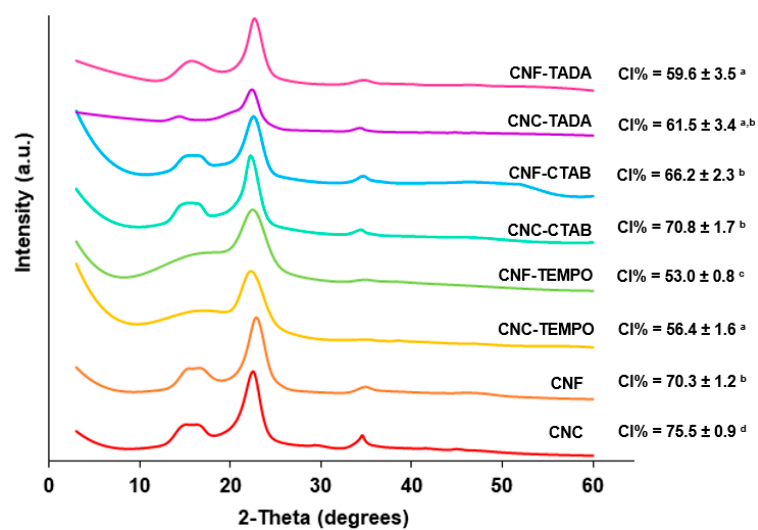
Figure 3. Powder X-Ray Diffraction analyses of the modified and unmodified cellulose nanocrystals (CNC) and cellulose nanofiber (CNF) materials. Nanocellulose modifications have been performed with cetyltrimethylammonium bromide (CTAB), tannic acid and decylamine (TADA), and by TEMPO-mediated oxidation (TEMPO). (Averages followed by the same letters in the same column do not differ statistically by Tukey’s test ( p > 0.05).